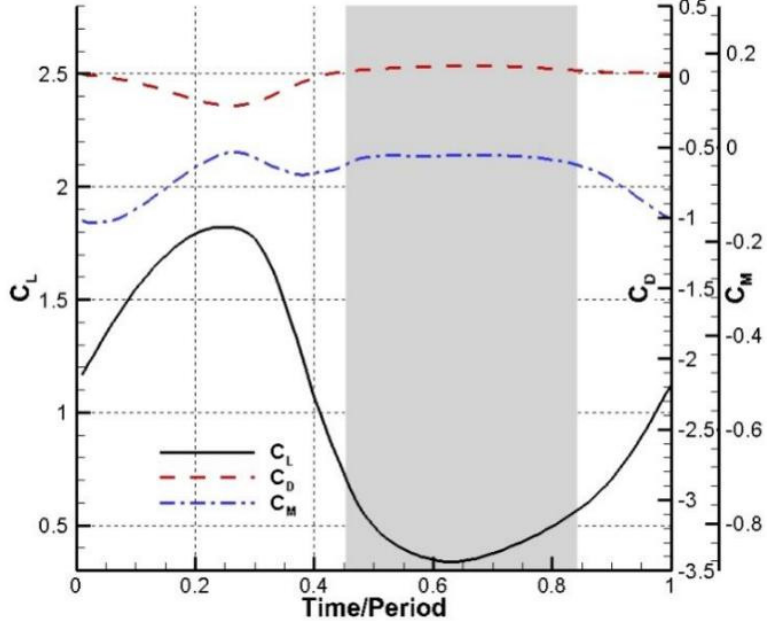
Figure 7. The variation of the coefficients of lift, drag, and pitching moment within a flapping period (gray shadow represents the course of upstroke).